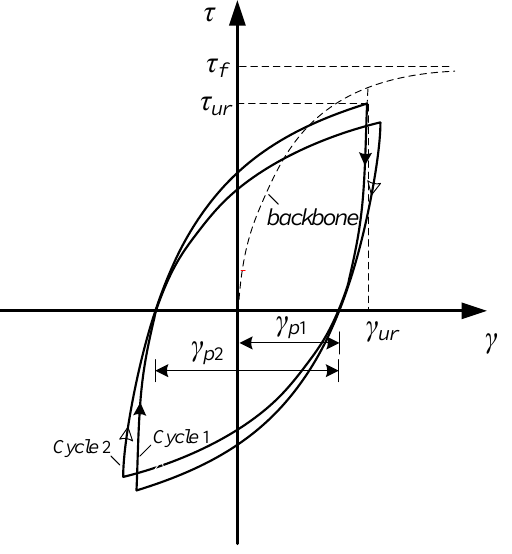
Figure 4. Illustration of hysteretic loops.